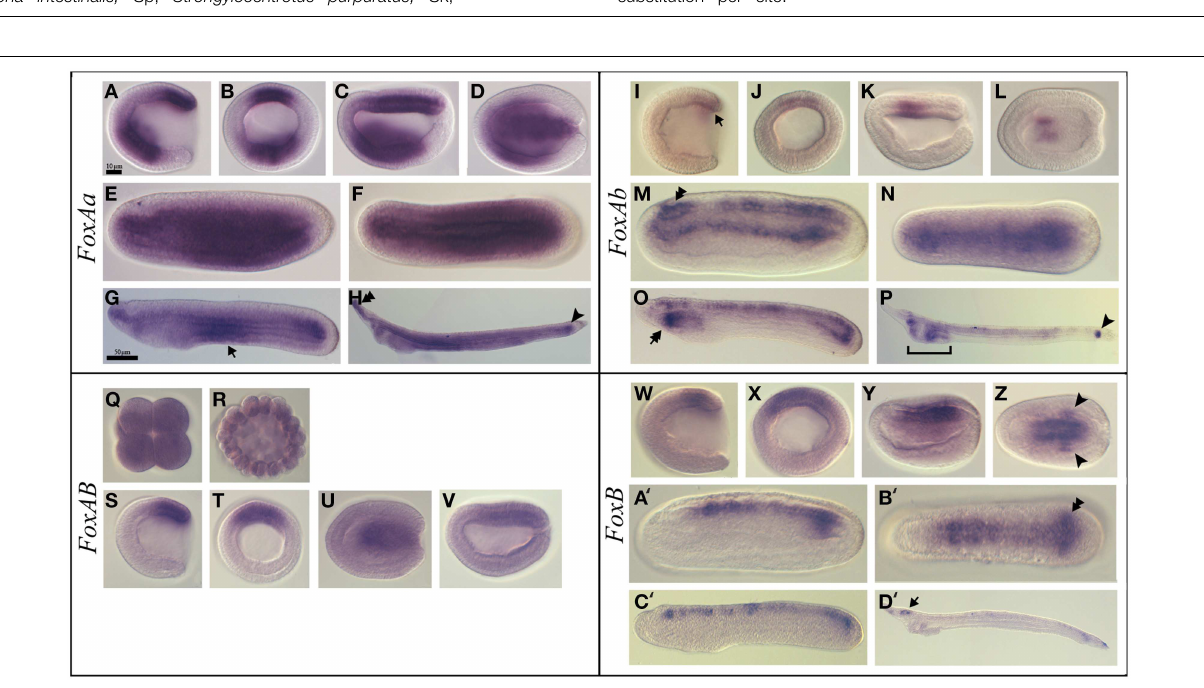
cerebral vesicle. In the late neurula lateral view (O) , the double arrow marks the expression in the most anterior part of the pharynx. In larva lateral view (P) the arrowhead indicates the expression in the tailbud. FoxAB expression pattern (Q–V) . Eight-cell stage (Q) . Blastula stage (R) . Gastrula lateral (S) and blasporal (T) views. Late gastrula lateral (U) and dorsal (V) views. FoxB expression pattern (W–D’) . Gastrula lateral (W) and blastoporal (X) views. Early neurula lateral view (Y) . In the early neurula dorsal (Z) view the arrowhead indicates the two expression patches in the posterior paraxial mesendoderm. Mid-late neurula lateral (A’) and dorsal (B’) views. The double arrowhead marks the expression in the newly formed somites. Late neurula lateral view (C’) . In larva lateral view (D’) the arrow indicates the expression in the cerebral vesicle. Scale bar: 10 µ m (A–F), (I–N) , (Q-V) , (W-B’) , and 50 µ m (G,H) , (O,P) , (C’,D’)